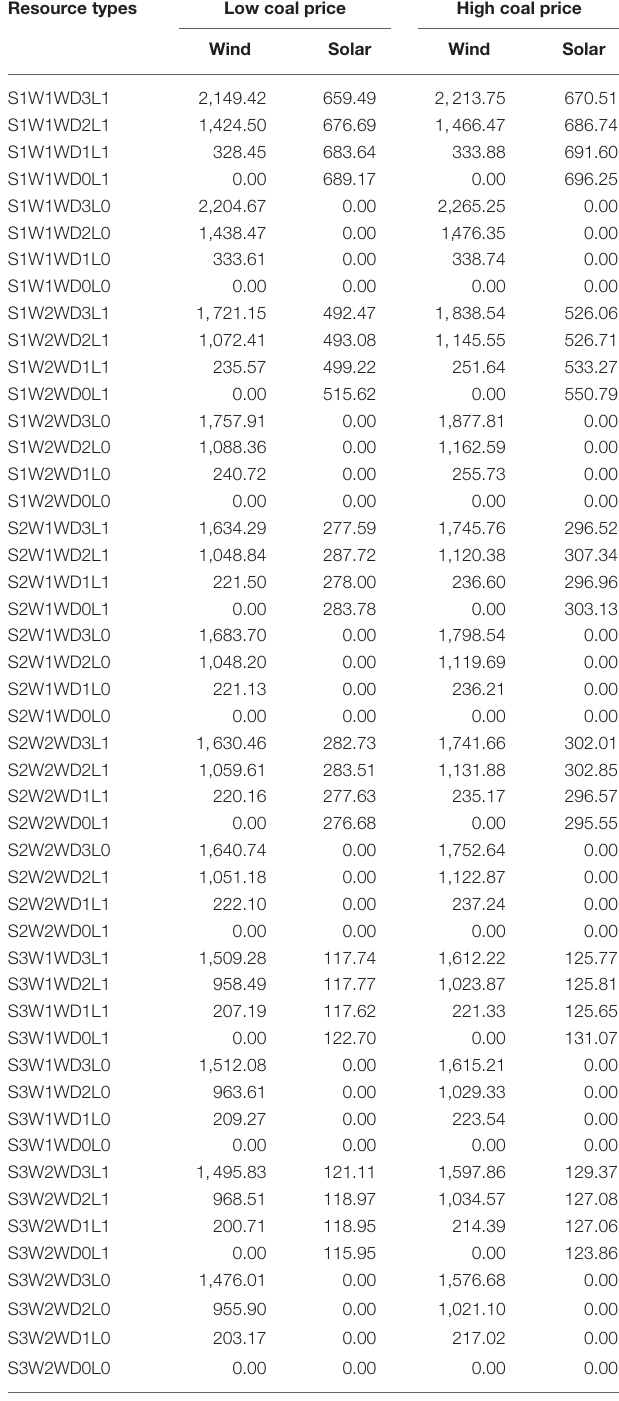
TABLE 2 | Typical daily return of wind and solar power generation under the market condition in Guangdong Unit: 10,000 CNY/day. Resource